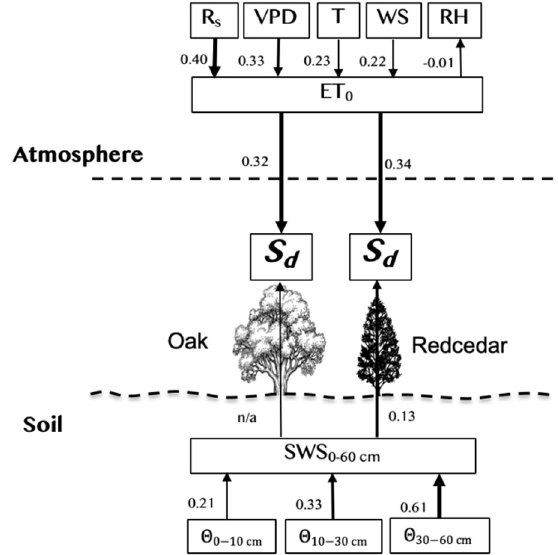
Figure 8. Cumulative daily water use of a redcedar stand (498 mm, ERC), post oak stand (557 mm, OAK), and redcedar and post oak mixed stand (635 mm, MIX).